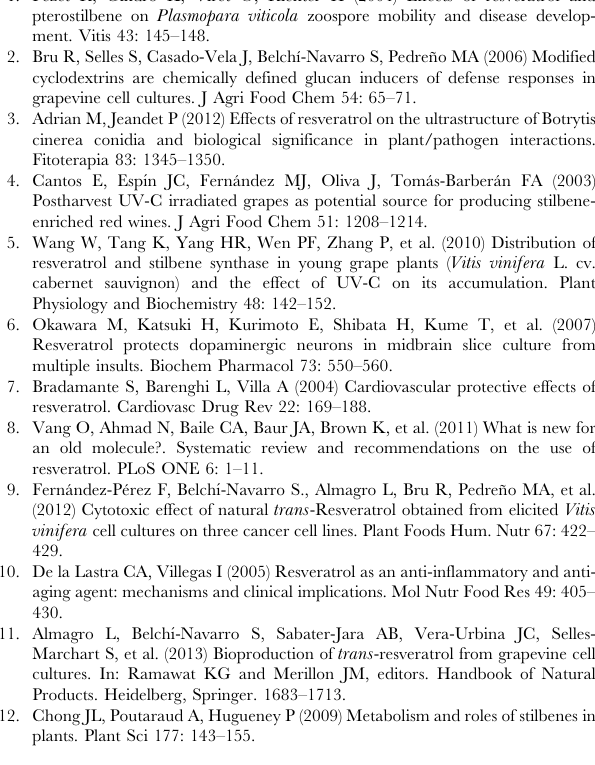
Figure S4 Mapman visualization of the significant genes in the ‘Transport overview’ pathway. Figure S5 Mapman visualization of the significant genes in the ‘Hormone signalling’ pathway. Table S1 PCR primers used to amplify gene-specific regions for expression analyses. Table S2 RMA normalized expression dataset. Log 2 RMA GrapeGen GeneChip probesets signal in each sample. Table S3 Probesets significantly regulated 24 h after any treatment. Table S4 Functional categories over-represented in each expression cluster of significantly regulated